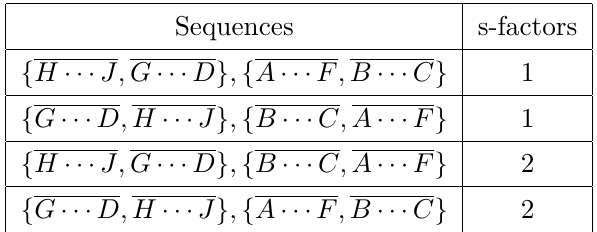
Table 6. Reducible diagrams of the Cweb and their s -factors.